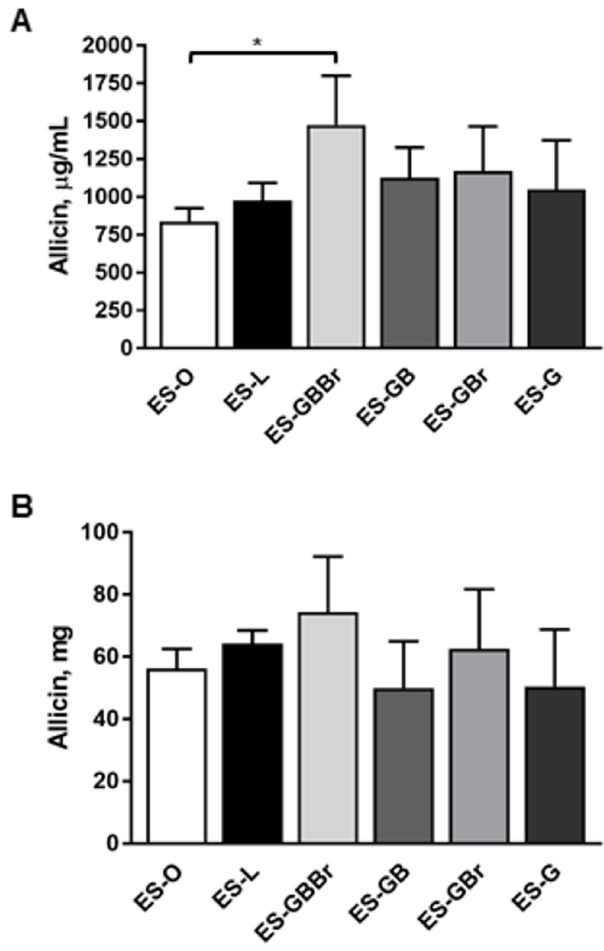
Fig 3. Quantitation of allicin in eyesalve formulations reveals significant differences in concentration but not overall yield. (A) Allicin concentration ( μ g/mL) was determined using Chenomx small-molecule library for 600 MHz ( 1 H Larmor frequency) magnetic field strength NMR. (B) Allicin production (mg) was calculated by accounting for volume differences between formulations. Data are presented as mean ± SD (n = 4). Significant differences ( p < 0.05, one-way ANOVA, Tukey’s multiple comparisons post-test) between formulations are indicated with asterisks.